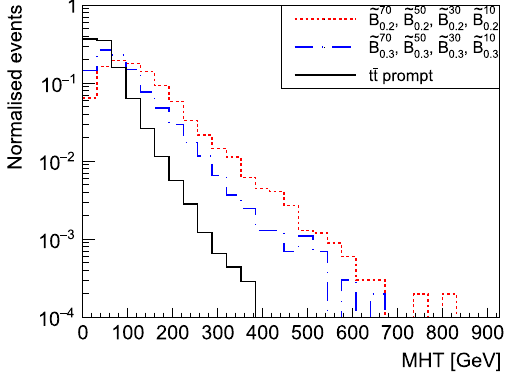
Fig. 15 Transverse impact parameter d 0 of the top quarks in the ˜ B -like = 300 GeV case with m ˜ χ 0 1